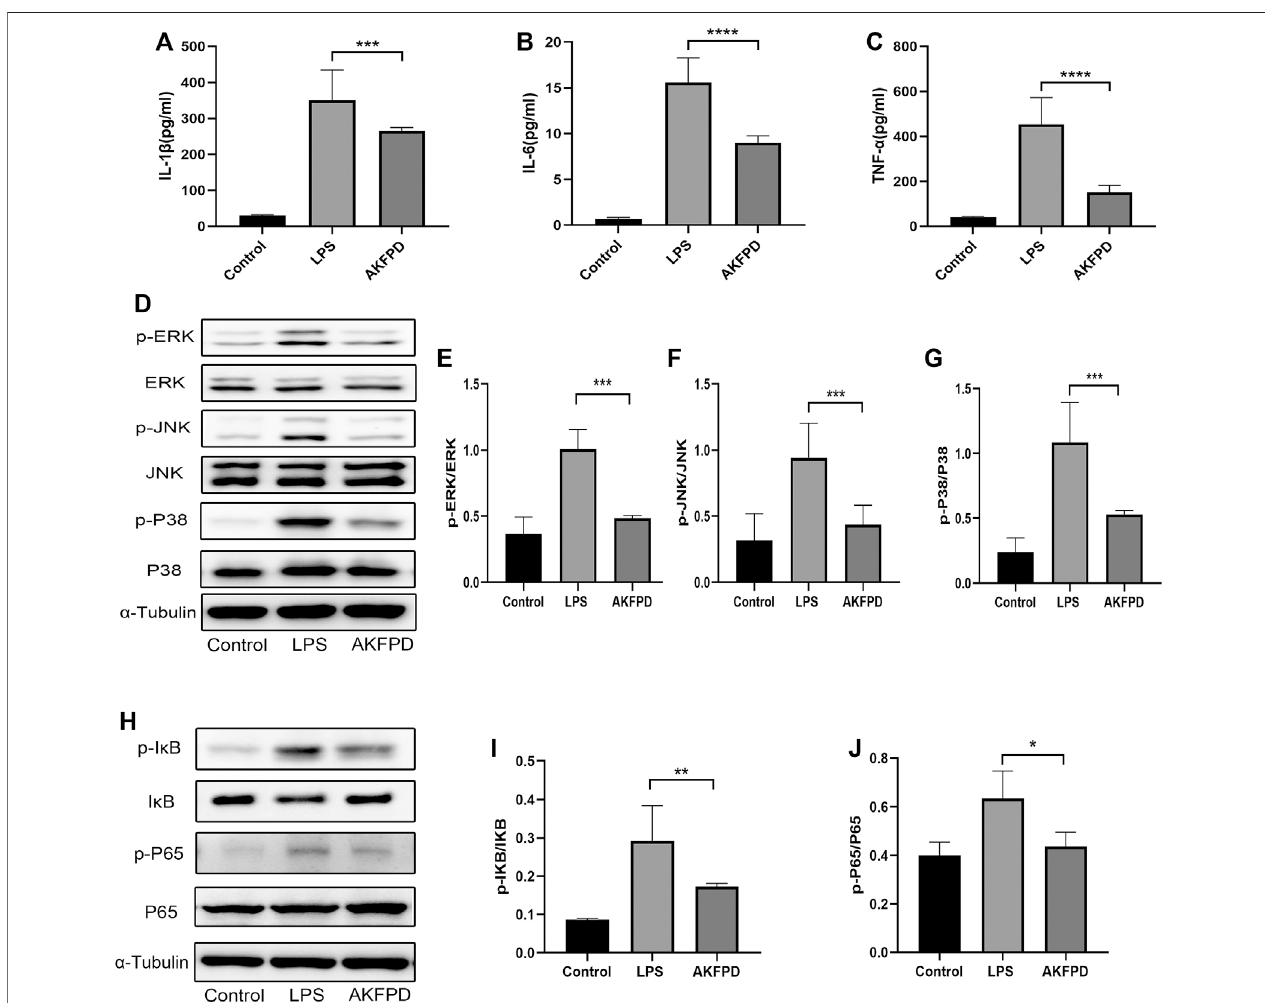
FIGURE6| Fluorofenidoneinhibitedin fl ammationbysuppressingactivationoftheNF- κ B/MAPKpathway invitro . (A – C) ELISAanalysisofIL-1 β ,TNF- α ,andIL-6in the supernatant of BMDMs in different groups. Western blot (D) and quantitative analysis of p-ERK (E) , p-JNK (F) , and p-P38 (G) proteins in BMDMs. Western blot (H) andquantitativeanalysisofpI κ B (I) andp-P65 (J) inBMDMs.Datawererepresentedasmean ± SD. n (cid:1) 4pergroup.* p < 0.05,** p < 0.01,*** p < 0.005,and**** p < 0.001 vs. the LPS group.